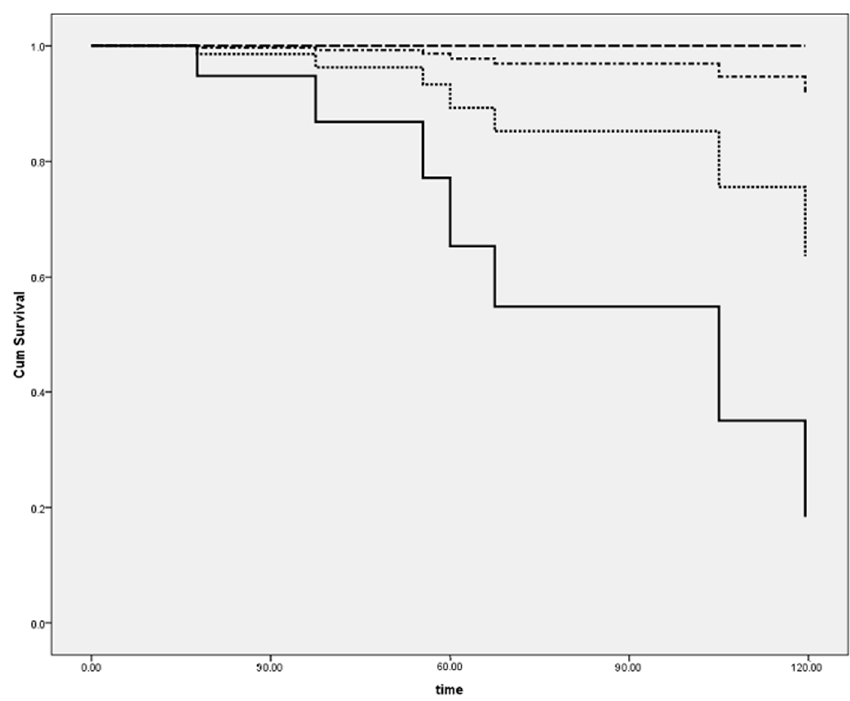
Figure 2. Analysis performed by separating groups according to the diagnosis (dilated cardiomyopathy (DCM) vs . myocarditis) and presence of a positive EMB. Consequently, four subgroups were created: DCM-negative polymerase chain reaction (PCR) (continuous line), DCM-positive PCR (dotted line), myocarditis (MYO)-negative PCR (dotted-dashed line), and MYO-positive PCR (dashed line). See text for explanation.